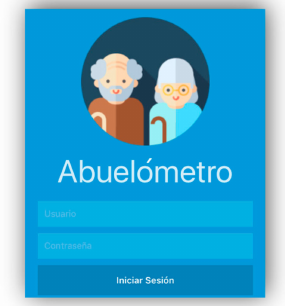
Figure 4. Login screen of Abuel ó